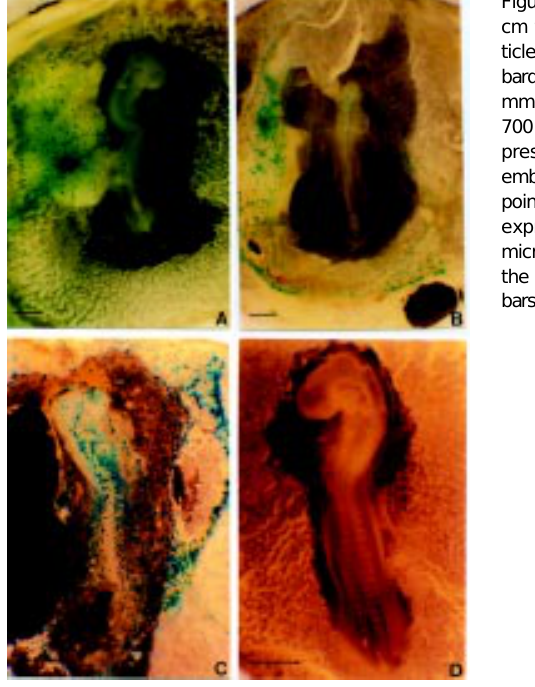
Figure 1. Embryos placed 0.5 cm from the center of the par- ticle dispersion cone and bom- barded with gold particles, 500 mmHg vacuum and 600 psi (A), 700 psi (B) or 800 psi (C) helium pressure. D , Non-bombarded embryo (negative control). Blue points indicate ß-galactosidase expression. The DNA-coated microparticle flying distance to the embryo was 8 cm. Scale bars = 1 mm.